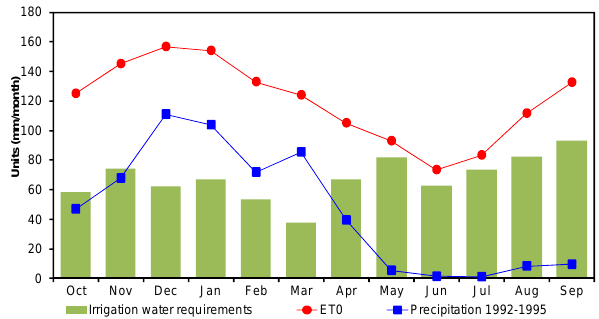
Figure 11. Irrigation water requirements during drought period 1992–1995 for the whole catchment.